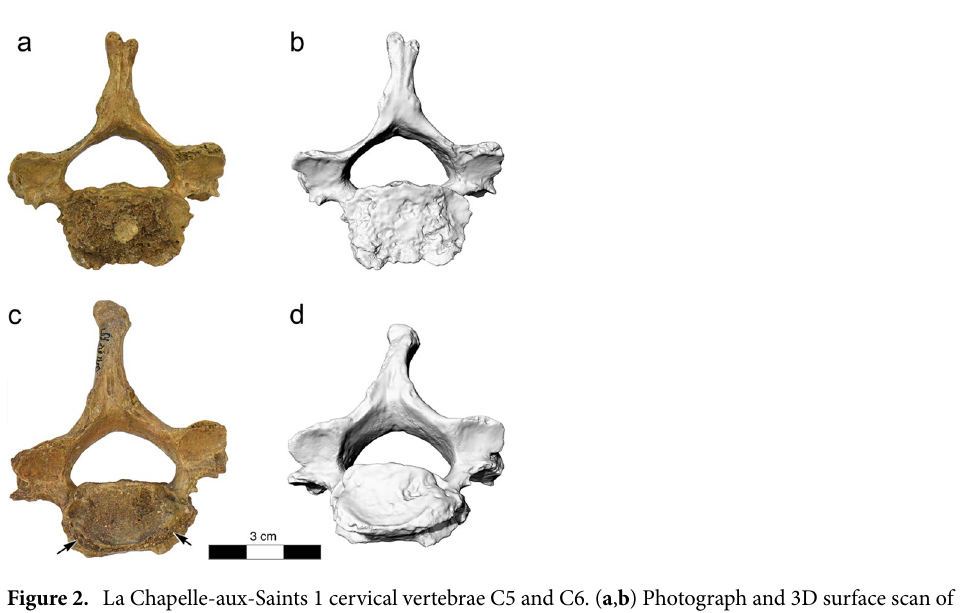
Figure 2. La Chapelle-aux-Saints 1 cervical vertebrae C5 and C6. ( a , b ) Photograph and 3D surface scan of vertebra C5, inferior view, ( c , d ) photograph and 3D surface scan of vertebra C6, inferior view. Note the marginal erosions